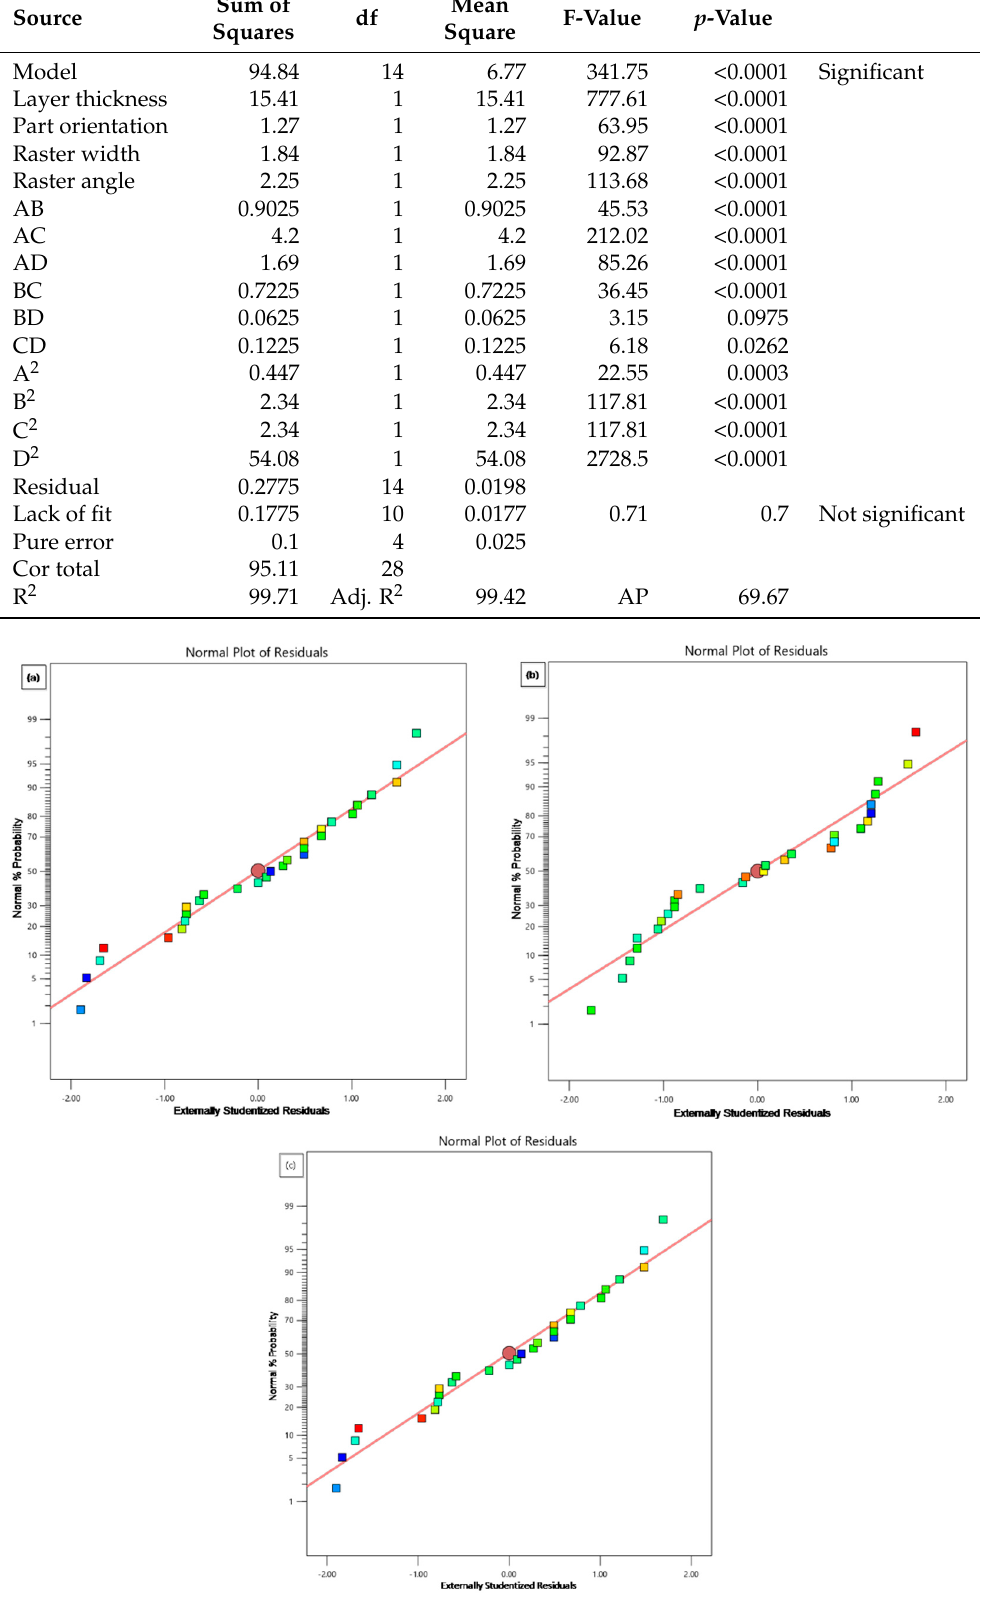
Figure 2. Normal probability plots for ( a ) Ra , ( b ) Rz and ( c ) Rq